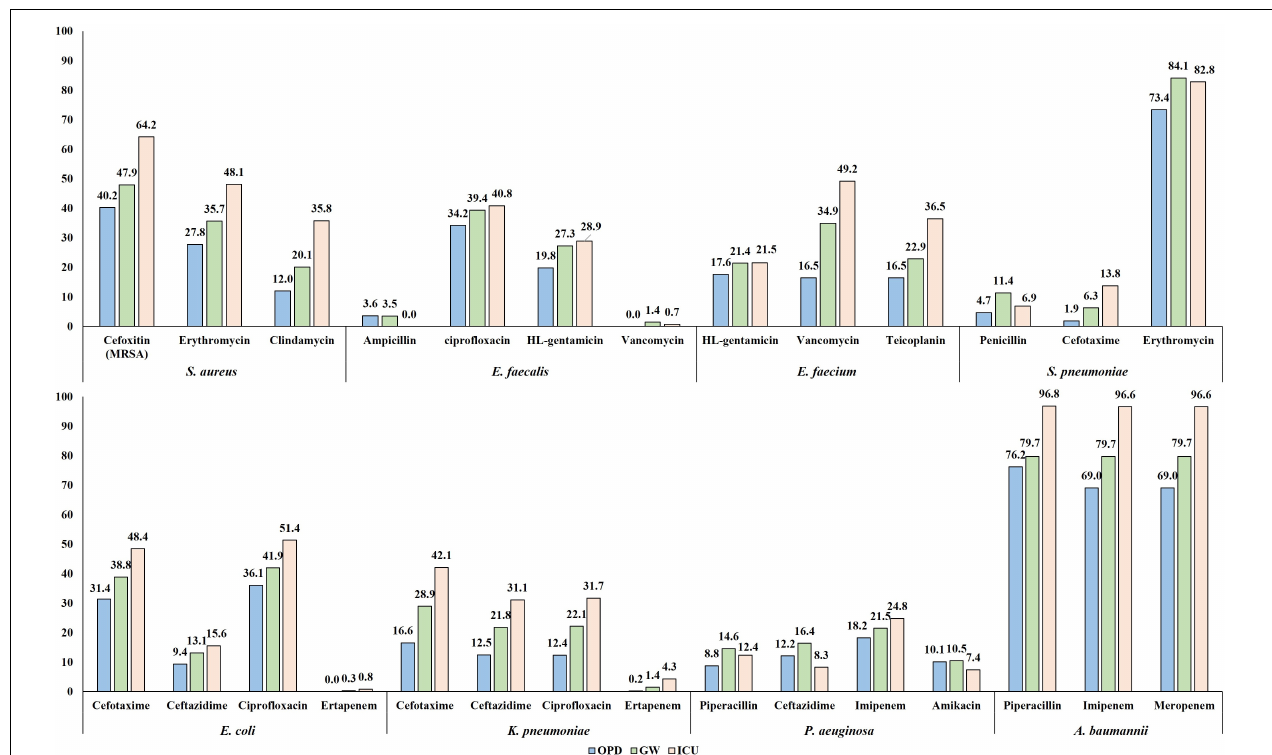
FIGURE 5 | The percentage of resistance to major antimicrobials of bloodstream infection-causing pathogens by admission type. The resistance rates determined by disk diffusion method are